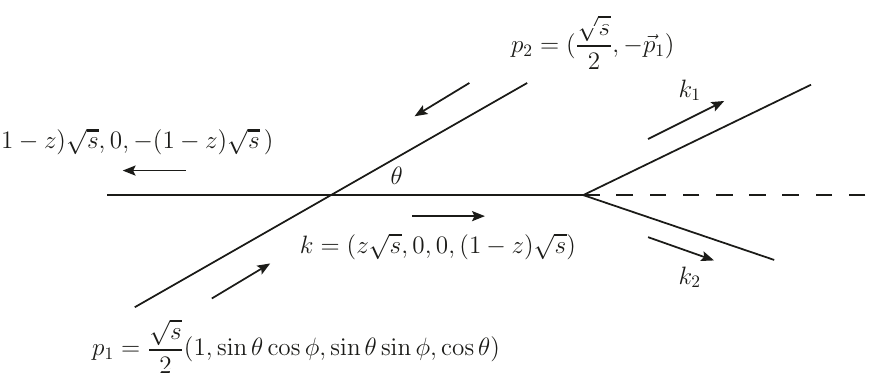
Figure 11 . Our coordinate system in p 1 p 2 center-of-mass frame and four momenta (see also figure